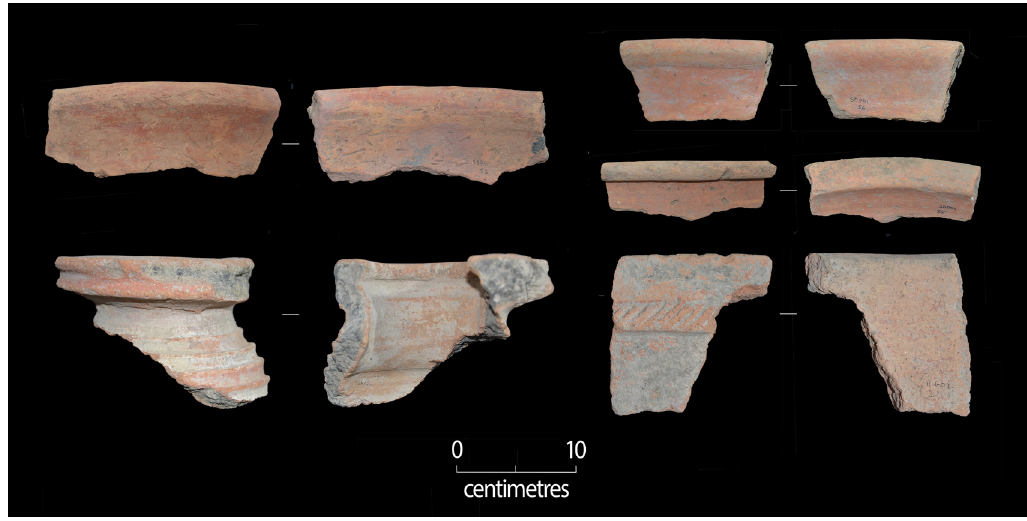
Figure 32: External and internal surfaces of five Class 10 variant 2